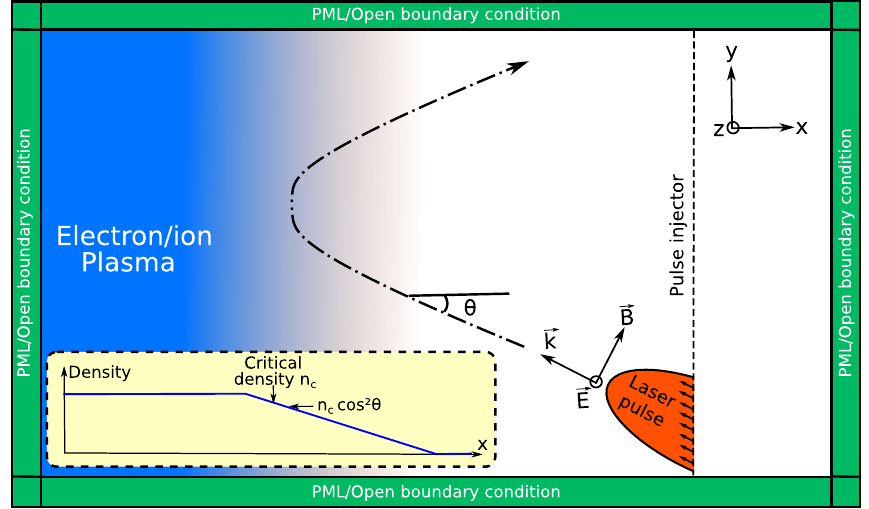
Figure 3. Numerical setup: A laser pulse in oblique incidence is injecting toward an overcritical plasma ramp. The laser pulse is reflected at the turning surface such as density n = n c cos